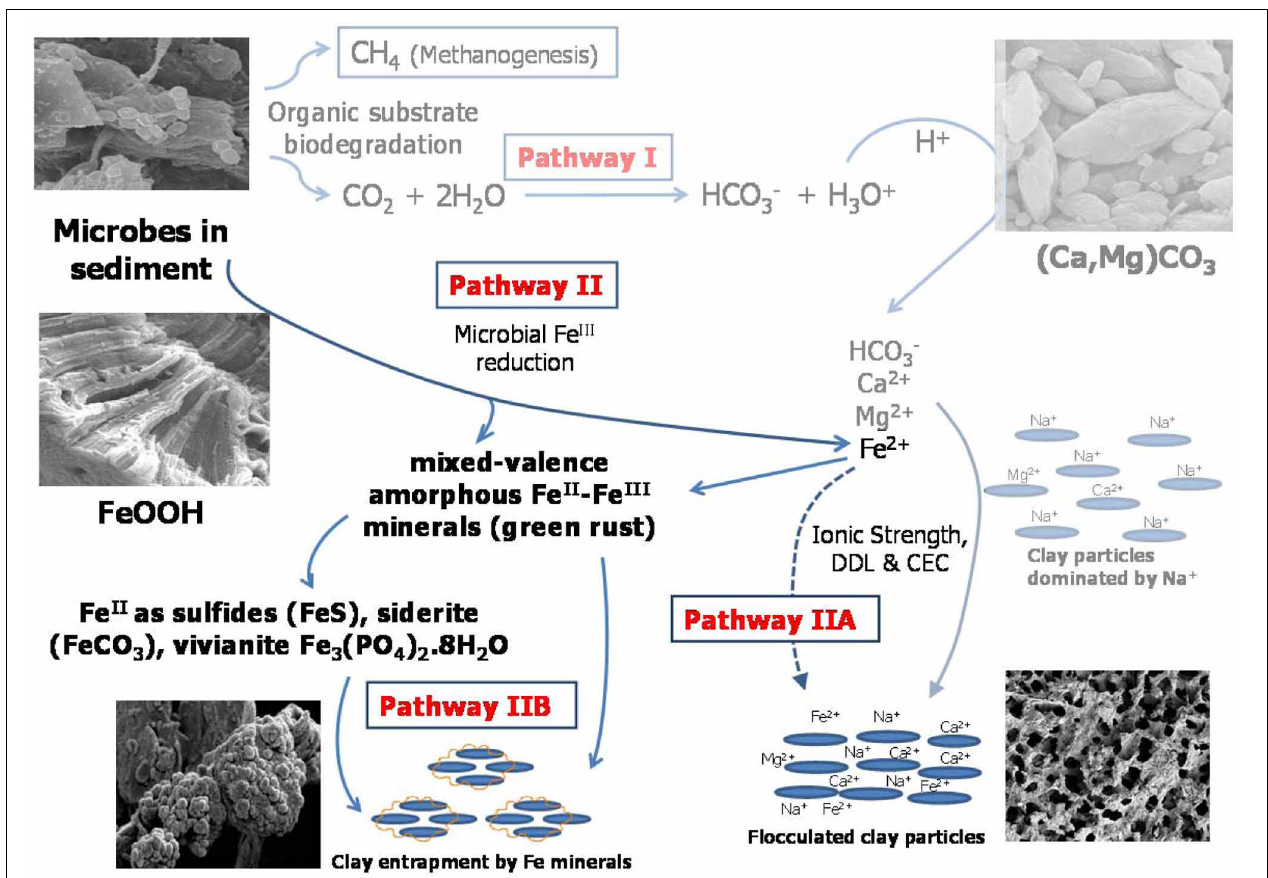
FIGURE 1 | Proposed model for microbially-mediated geochemical pathways of clay consolidation, modified from Figure 7 in companion paper (Siddique et al., 2014). In Pathway I, microbial metabolism decreases pH and dissolves carbonate minerals in MFT, increasing bicarbonate (HCO − 3 ), calcium (Ca 2 + ), and magnesium (Mg 2 + ) ions in porewater. These ions increase ionic strength ( I ) of porewater, thus reducing the diffuse double layer (DDL) of clay particles and facilitating their consolidation. In Pathway II under anaerobic conditions, Fe III minerals (goethite and ferrihydrite; FeOOH) in tailings are reduced